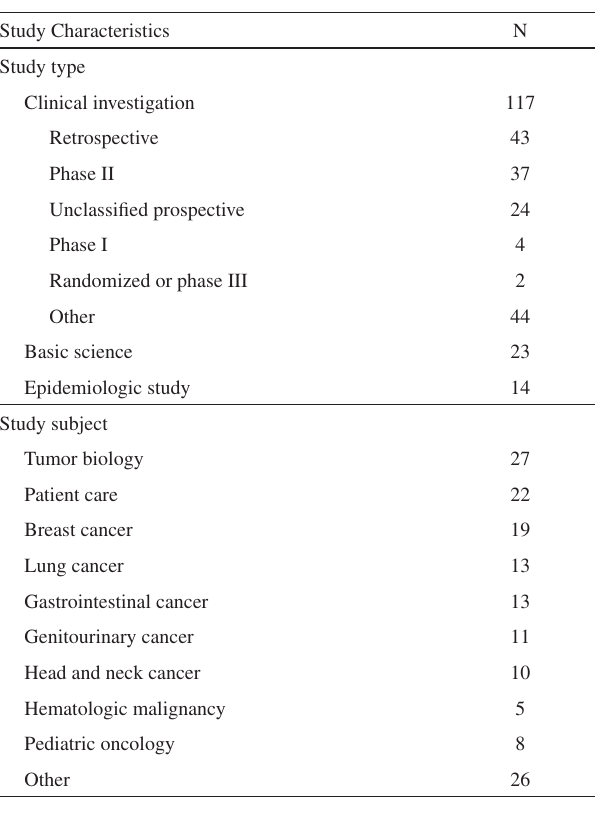
Table 1 - Type and subject matter of Brazilian studies (N=154)